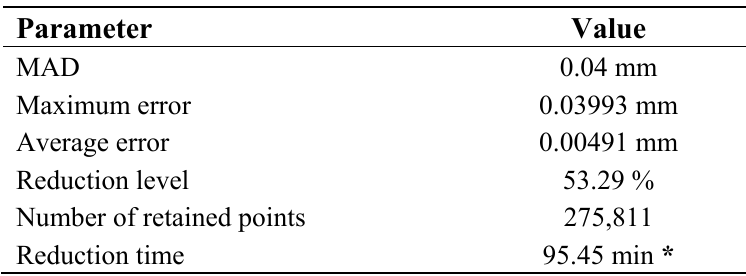
Table 3. The point data reduction